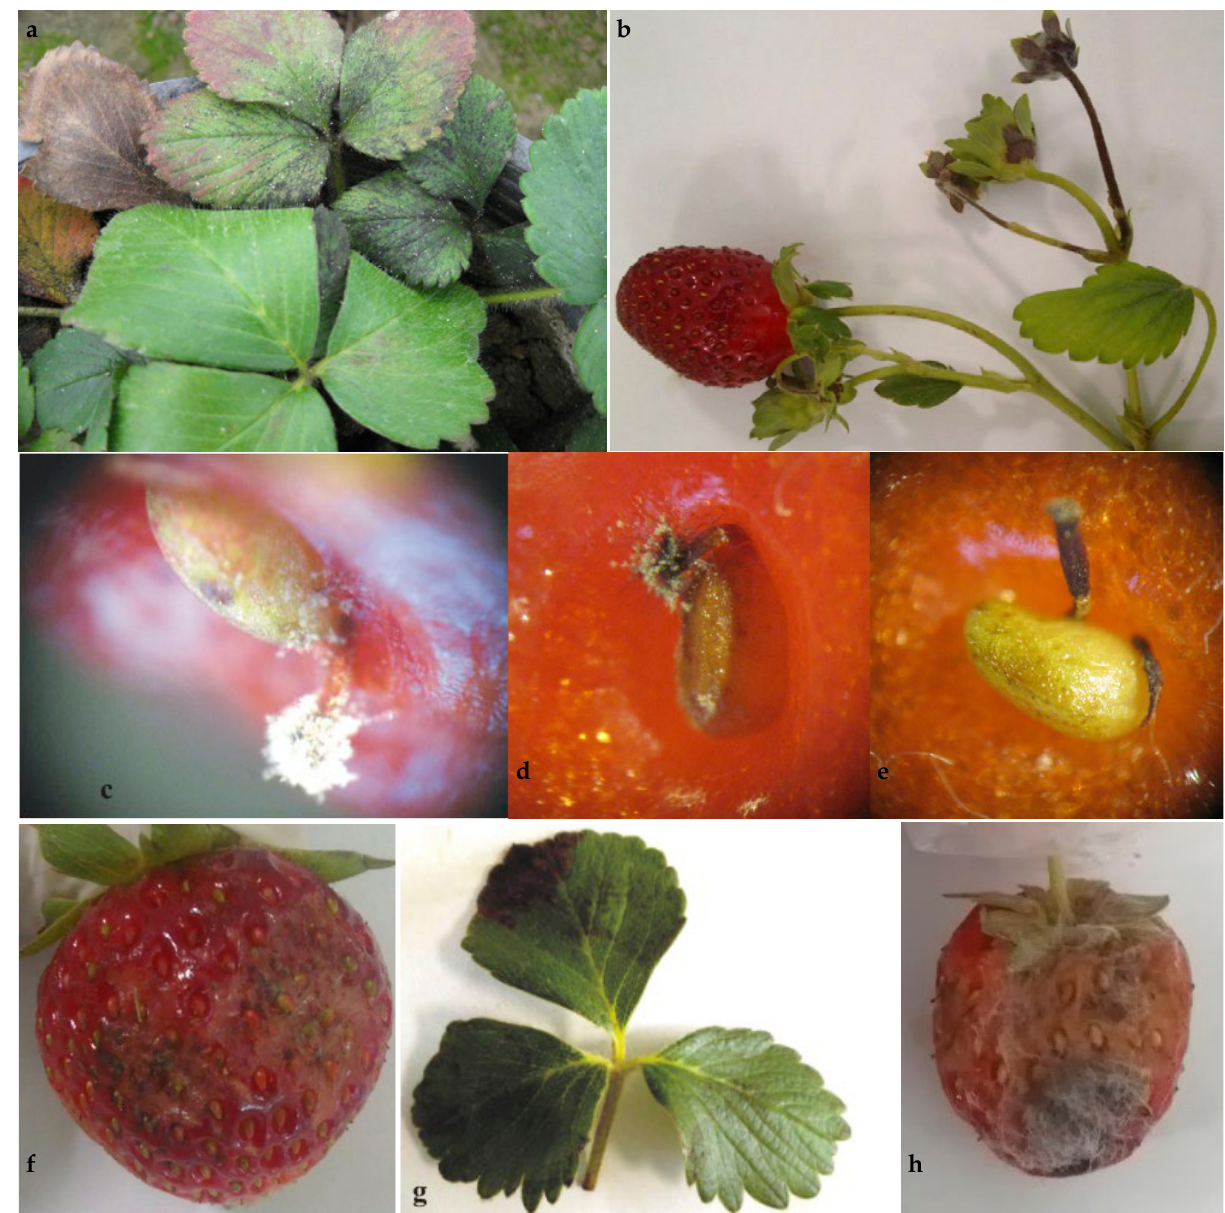
Figure 1. Symptoms of disease on leaves, fruits and flowers by Cladosporium macrocarpum and C. limoniforme in the field. (a) Black sooty mold symptoms on leaves. (b) Flower and fruit blight. (c–f) Fruit rot stages induced by C. macrocarpum in pathogenicity test starting from achenes . ( g–h ) Symptoms on strawberry inoculated with a conidial suspension of C. limoniforme , g. on leaf, h. on